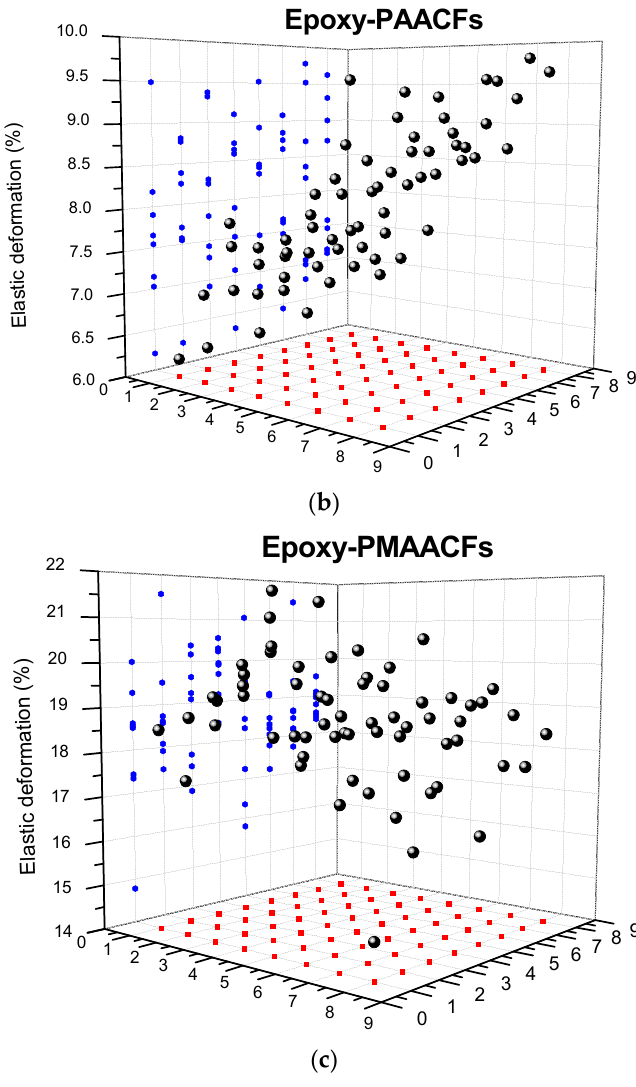
Figure 7. Elastic deformation (recovery) obtained from the loading ‐ unloading mapping measurements at 200 nm of displacement, for ( a ) epoxy ‐ CFs (benchmark), ( b ) epoxy ‐ PAACF (low resistance to applied load), and ( c ) epoxy ‐ PMAACFs samples (high resistance to applied load). Elastic modulus (values referring to epoxy, affected by extent of interfacial adhesion and, thus, overall CFRP integrity) mapping for all samples showed that for the case of epoxy ‐ PMAACFs, higher values (~3.5 GPa) are evidenced; this is also consistent with values from Figure 6, as it is denoted that higher applied loads are required for reaching 200 nm of displacement, comparing this with all other samples (of which the max. modulus values reached ~1.7 GPa). In Figures 8–11, elastic modulus obtained from nanoindentation mapping measurements at 200 nm of displacement for all samples are presented. The 64 points are presented in red dots (base, X–Y axes), while elastic modulus values are presented in black; through trajection (blue colour), the deviation range of elastic moduli is depicted. epoxy ‐ PMAACFs sample exhibits the highest elastic moduli range (up to ~3.4 GPa), while rest of the samples exhibit elastic moduli range up to ~1.7 GPa.